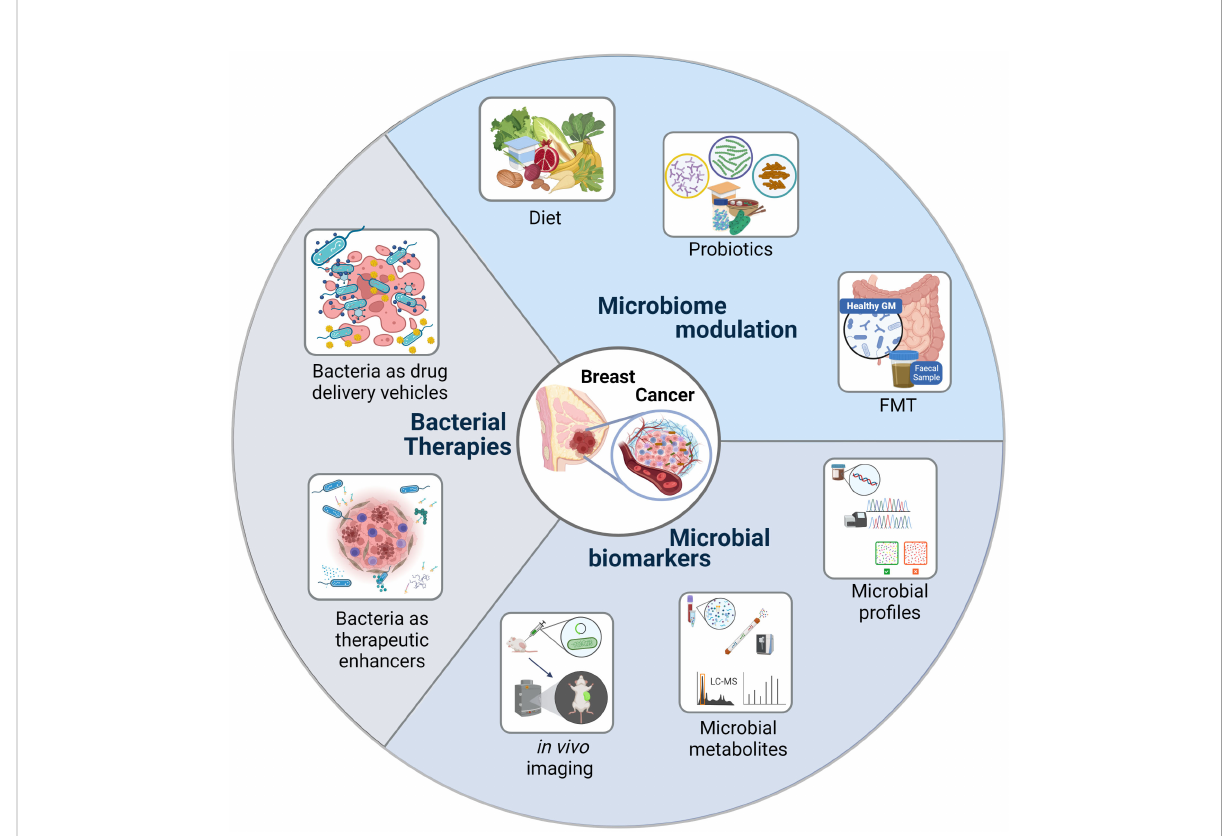
FIGURE 3 Bacteria as Cancer Theranostics. Harnessing the potentials of the microbiome to treat/prevent triple negative breast